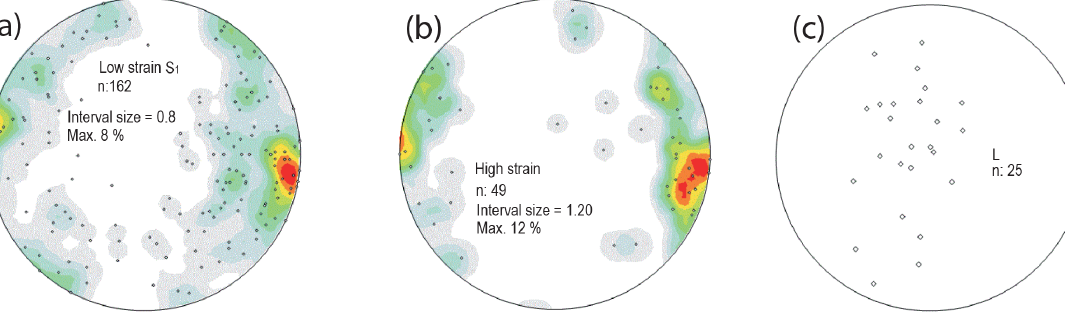
Figure 6. Stereographic equal-area projections highlighting (a) low-strain S 1 , (b) high-strain S fabrics, and (c) stretching and mineral lin- eations.